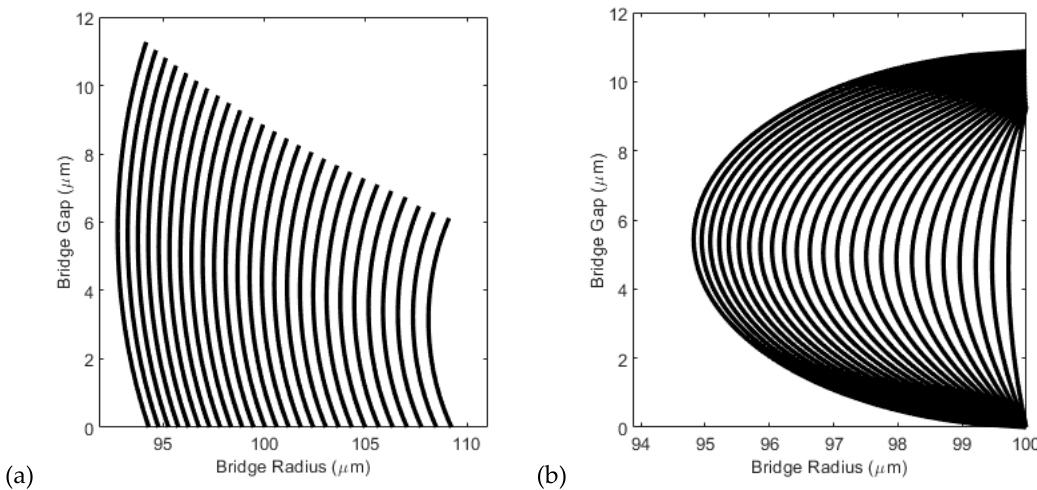
Figure A1. Example of the geometry of a typical liquid bridge as it varies with the bridge gap, as defined by Equation A.3. (a) The contact angle is constant (60°); (b) the contact angle varies (between 5° and 85°). The volume of the bridge is 𝝅 × 𝟏𝟎 (cid:2879)𝟏 nL and the Bond number is 0.0022.